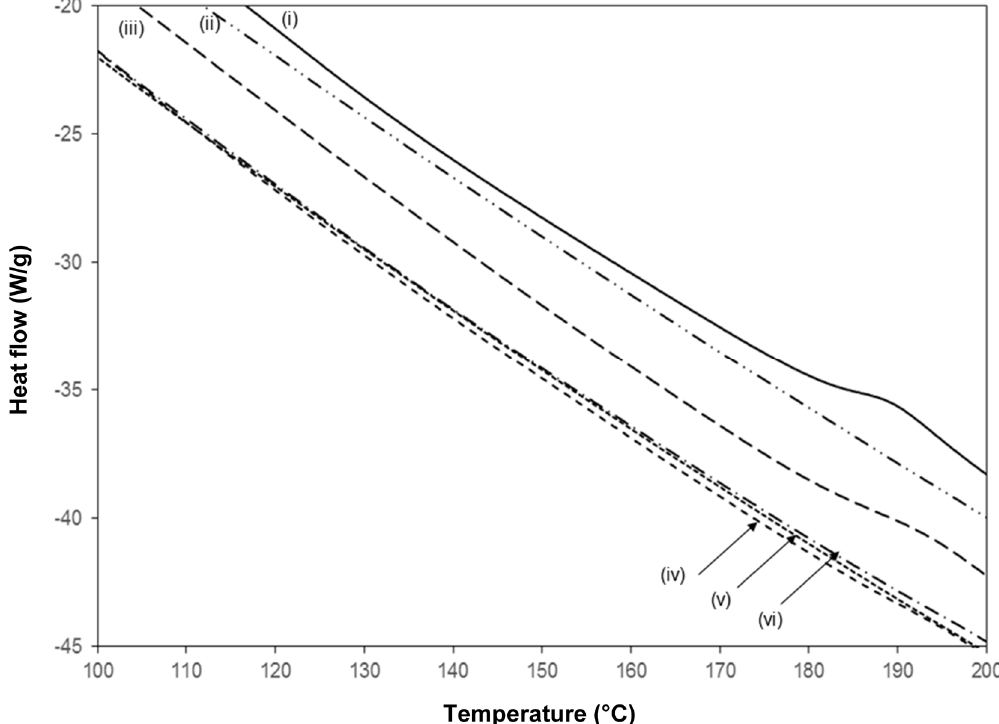
Figure 12. Detail of DSC curves during second heating run from 0–250 °C for ( i ) SMI, ( ii ) Kln, ( iii ) chemically reacted Kln/SMI = 70:30, ( iv ) physically mixed Kln/SMI = 70:30,